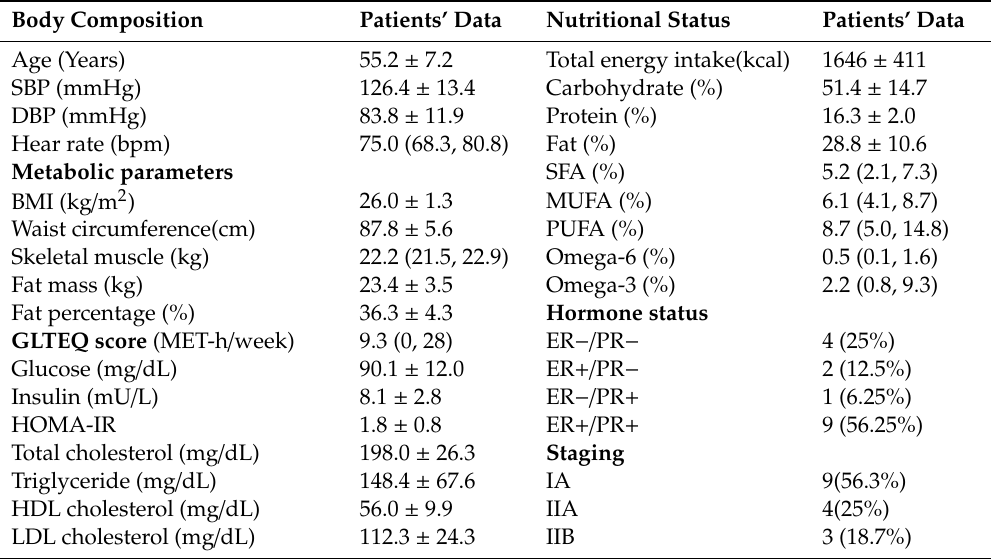
Table 1. Baseline characteristics of study participants ( n =